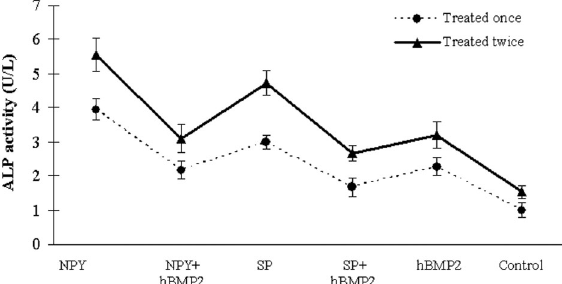
Figure 4. Alkaline phosphatase (ALP) activity assay. The graph shows the ALP activity of the osteoblasts treated with 0.1 m g/mL neuropeptide Y (NPY), substance P (SP) and human bone morphogenetic protein 2 (hBMP2) alone, as well as their combined applications. Cells were treated once or twice. In this assay, all treatments induced statistically significant increases (P , 0.05, ANOVA) in ALP activity after the osteoblasts were treated twice compared with those treated once. The levels of ALP activity in cells exposed to NPY were the highest. Moreover, the ALP activity of cells exposed to 0.1 m g/mL neuropeptides alone was also significantly higher than that of the osteoblasts exposed to neuropeptides combined with human bone morpho- genetic protein